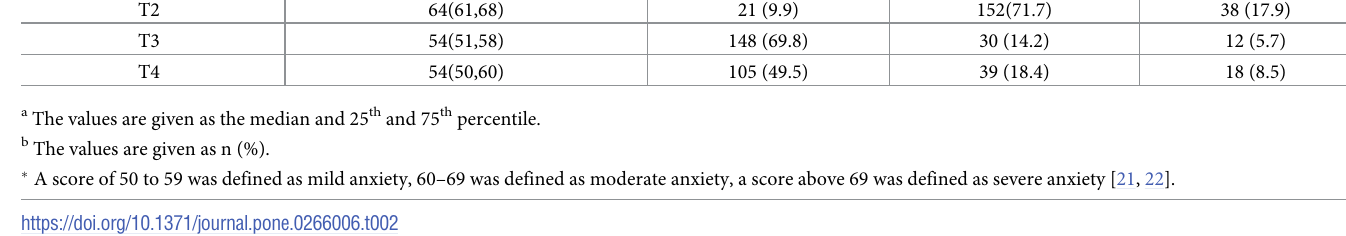
The results showed that the anxiety score of T1 was 57(55,61), 140 cases were mild anxiety. The anxiety score of T2 was 64(61,68), the patients with mild, moderate and severe anxiety were 21 cases, 152 cases and 38 case respectively. The anxiety score of T3 was 54(51,58), the patients with mild, moderate and severe anxiety were 148 cases,30 cases, and 12 cases respec- tively. The anxiety score of T4 was 54(50,60), mild, moderate and severe anxiety were 105 cases, 39 cases and 18 cases respectively. Table 2 shows the details.